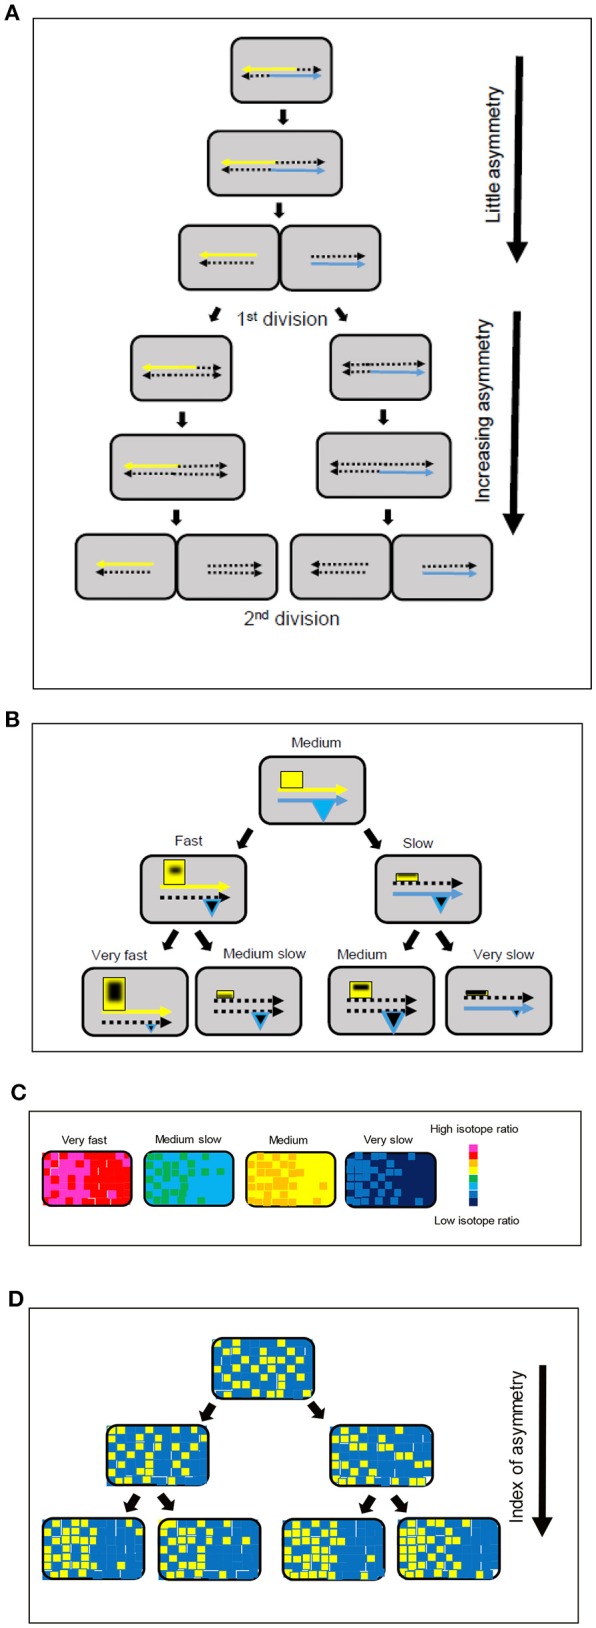
Model for strand-directed diversity and asymmetry. (A) The labeling of the chromosome and associated macromolecules during replication and segregation makes a greater contribution to intracellular asymmetry after the first division. (B) Positive feedback and association with the parental DNA strands leads to an increase in the size of hyperstructures (yellow rectangles) responsible for fast growth in one daughter cell and a decrease in the size of these hyperstructures in the other daughter cell, as shown in the left-hand branch; this tendency continues into the next generation. There is a corresponding decrease in expression of the hyperstructures responsible for fast growth, as shown in the right-hand branch; in parallel, expression of the hyperstructures responsible for survival (blue triangles) can either be maintained or decrease. The continuous yellow and blue arrows represent the parental DNA strands, the dotted arrows represent newly synthesized strands, and the black shapes within the hyperstructures represent 15N-labeled material. (C) Growth rate diversity in the four, second generation cells in the bottom line of (B) shown using a chromatic scale. (D) Increase in index of intracellular asymmetry (arrow) shown by classing pixels above (yellow) or below (blue) the median of the isotope ratio for the pixels within a single bacterium for the four, second generation, cells in (B). Comparison of the same cells in (C,D) shows that there is no contradiction between the evidence for the lack of importance of the intracellular asymmetry of labeled/unlabeled material in the actual estimation of mass doubling times (C) and the evidence for the importance of strand-based asymmetry as a mechanism for generating intercellular diversity (D).